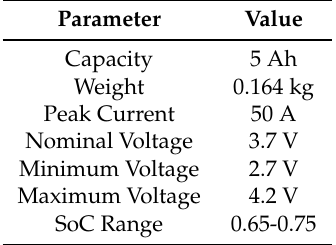
Table 5. Cell specification.